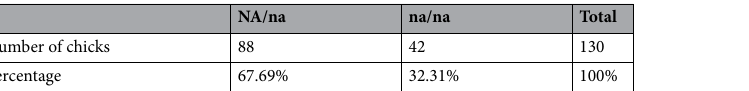
Table 4. Parental identification of chicks produced by Dnadarawi mothers. NA/na heterozygous, na/na normal feathered.